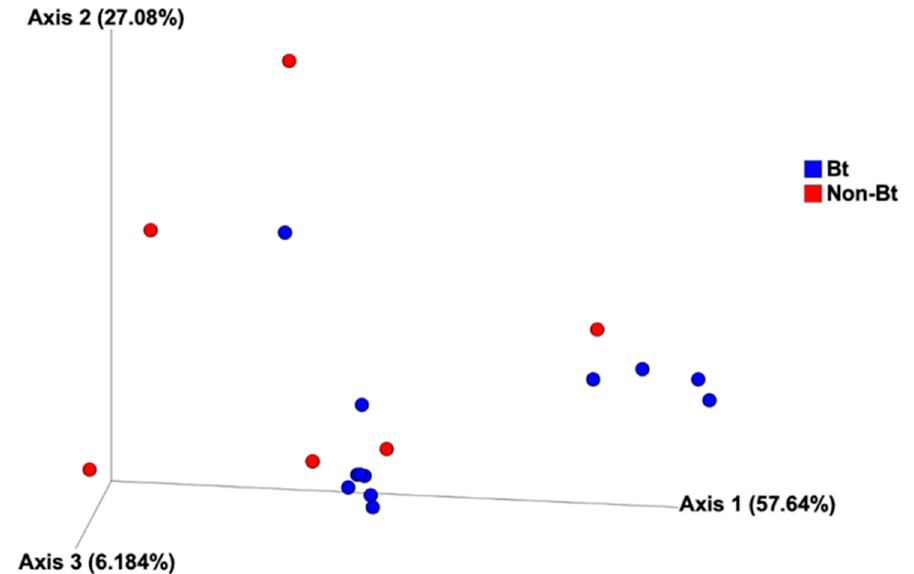
Figure 6. Principal coordinate analysis of bacterial composition of third stadium bollworms Helicoverpa zea collected from non-Bt cotton and Bt (WideStrike) in season 2. Analysis is based on the weighted Unifrac metric.